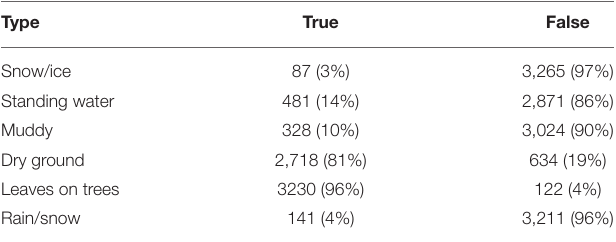
TABLE 1 | Surface conditions are recorded with each GLOBE Observer Land Cover observation.